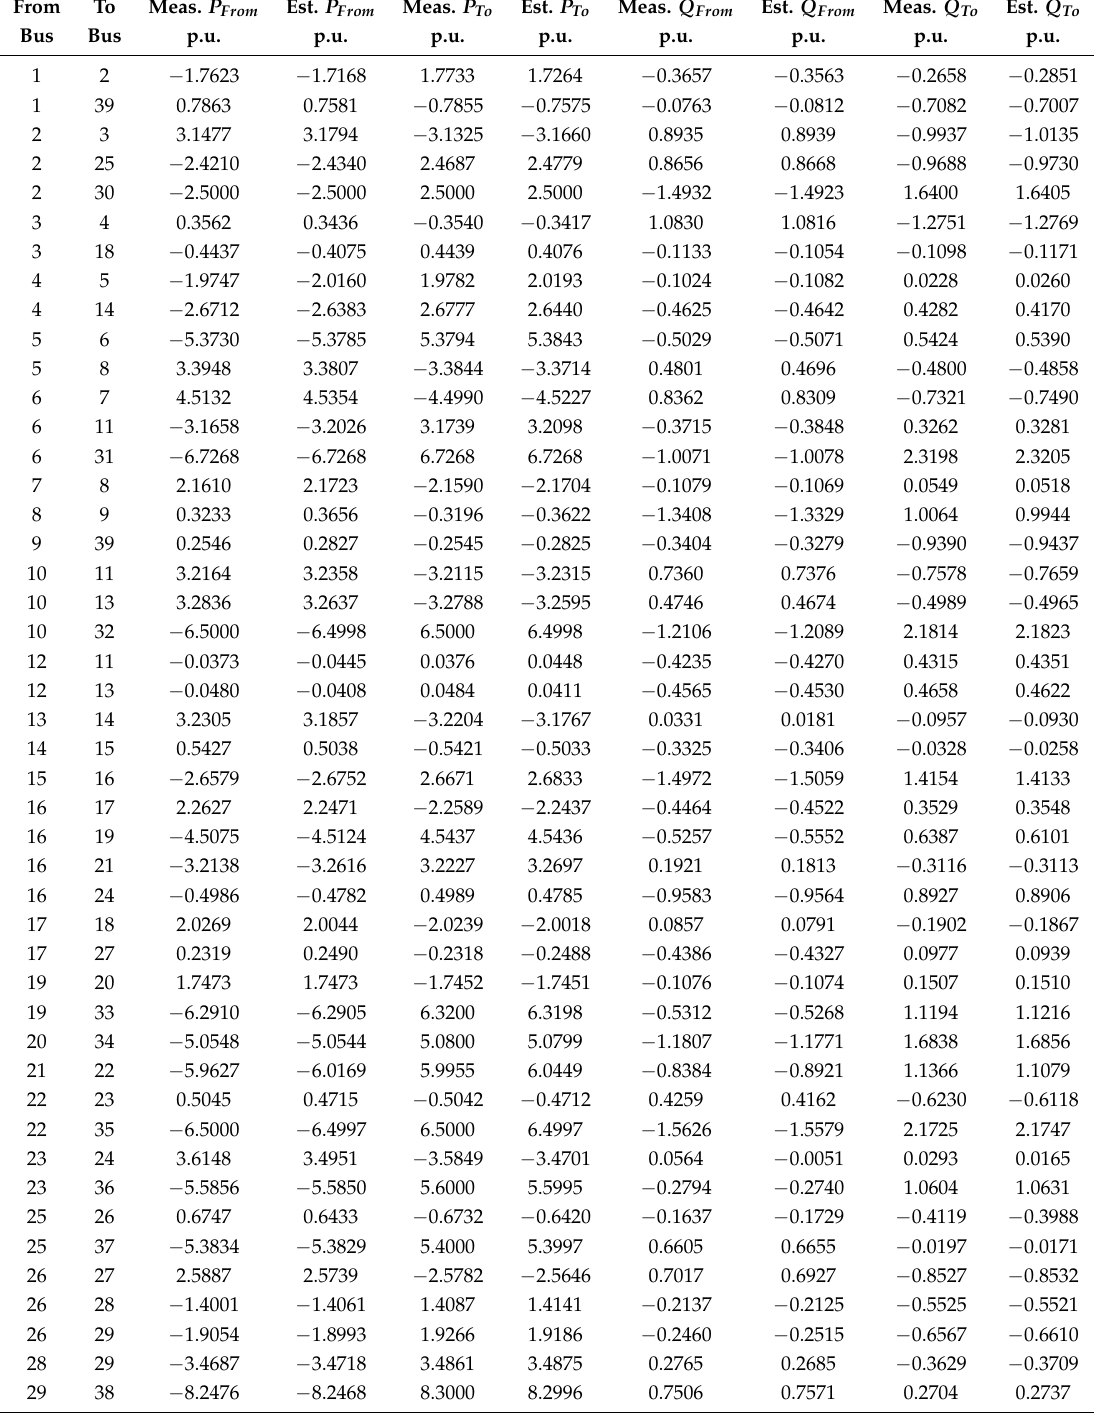
Table A2. Comparison of Measurements and their Estimations of IEEE 39 Test System for the Summer Case after the First Step of the Presented Method using Base Model Calculated for 20 ◦ C. From To Meas. P From Est. P From Meas. P To Est. P To Meas. Q From Est. Q From Meas. Q To Est. Q To Bus